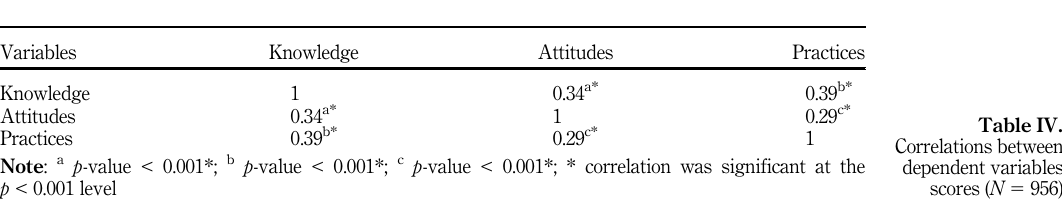
Table IV. Correlations